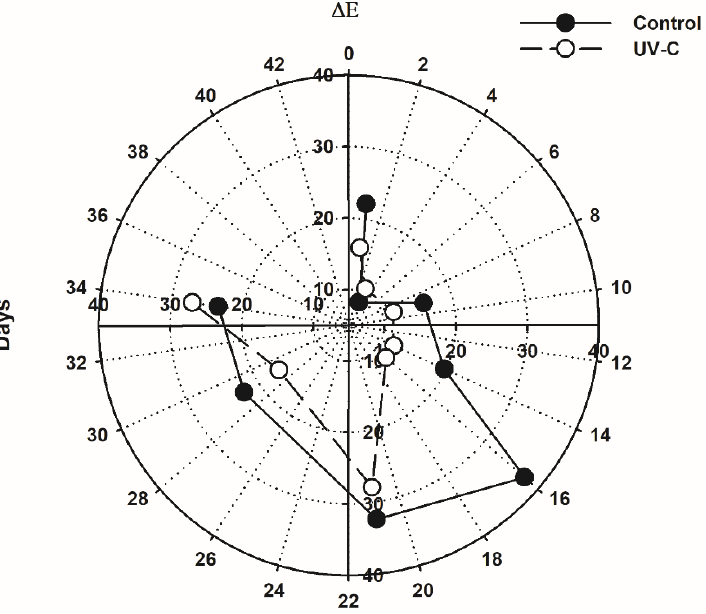
Figure 4. Leaf colour difference ( ∆ E) of P. × hortorum stem cuttings irradiated with 1 kJ m − 2 or left nonirradiated (controls) over a 6-week period. Significant differences between treatment means were calculated at p = 0.05.